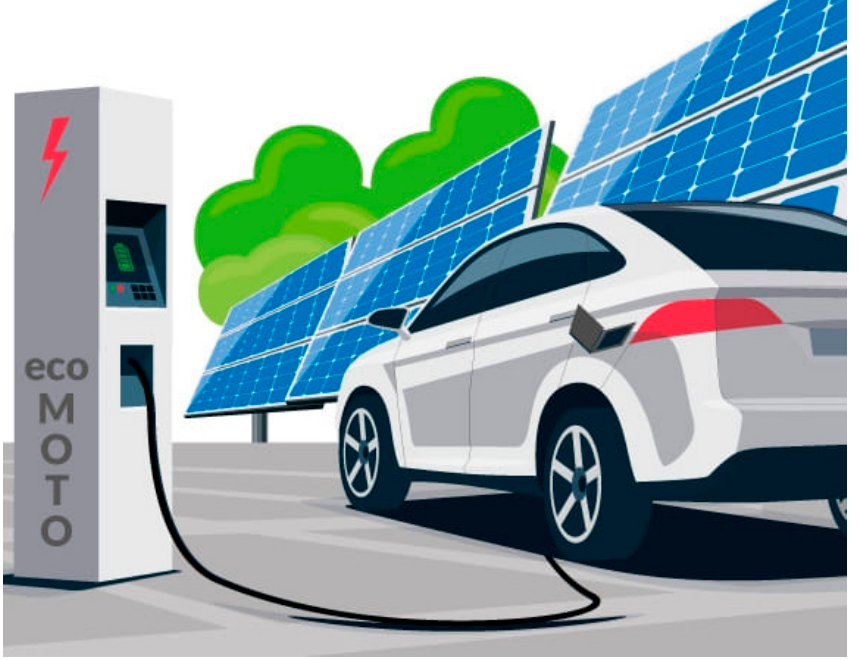
Figure 2. Charging electric vehicles with renewable energy.